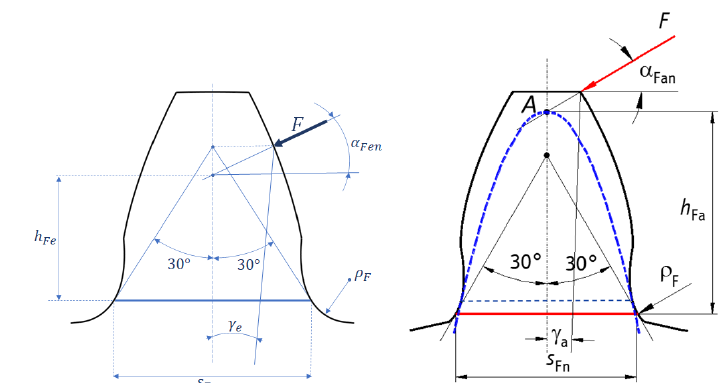
Figure 2. Tooth bending strength calculation as detailed AGMA [5] and ISO [6]. For an explanation of the depicted quantities, the reader is referred to the cited standards.